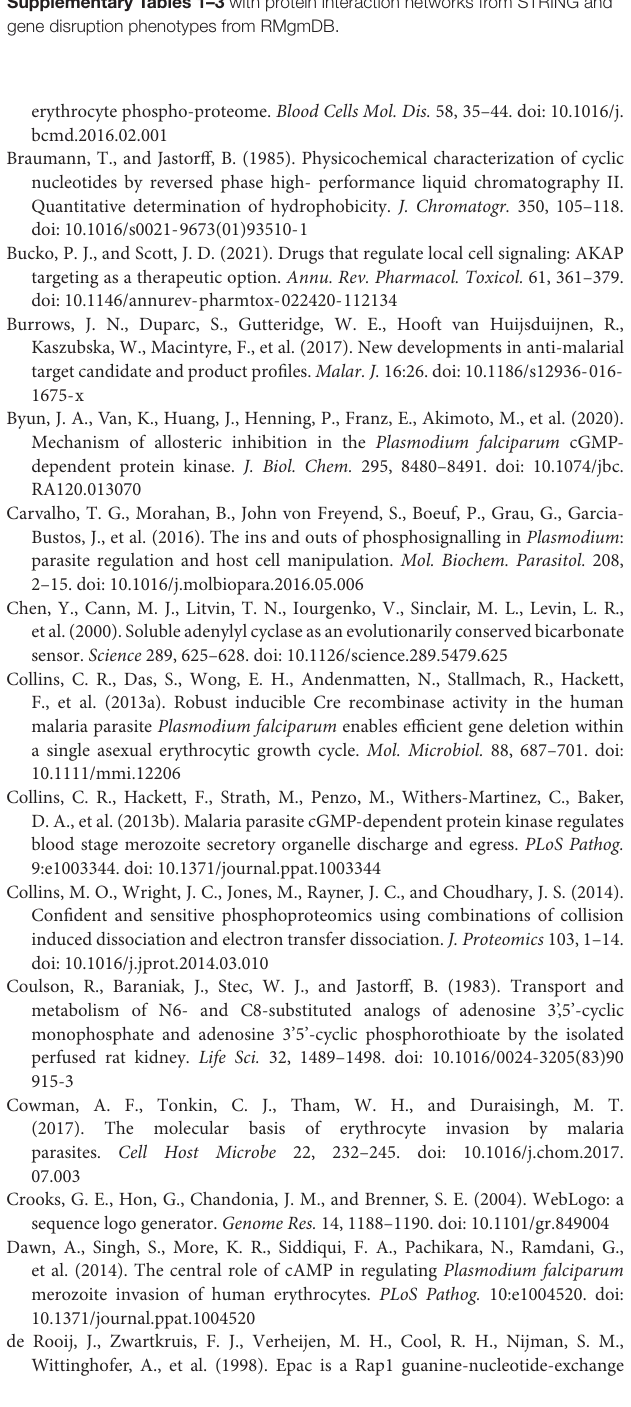
Supplementary Table 3 | Potential PfPKA substrate phosphorylation sites from 12 P. falciparum phosphoproteome studies with presence of core PKA phosphorylation motif and interaction with PKA. Supplementary Table 4 | Putative PfPKA substate proteins from Supplementary Tables 1–3 with protein interaction networks from STRING and gene disruption phenotypes from